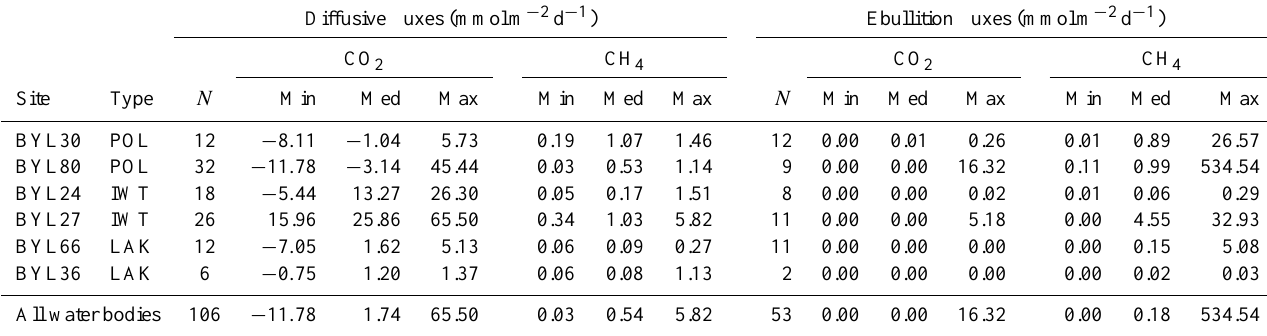
Table 3. Diffusive and ebullition fluxes of CO 2 and CH 4 for the six priority ponds and lakes sampled during 2 consecutive years (2013 and 2014). POL = polygonal pond; IWT = ice wedge trough pond; LAK = lake; Min = minimum; Med = median; Max =